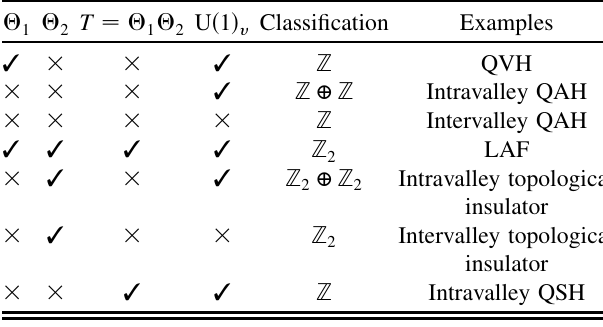
TABLE II. Classification of spinful SPT insulators on multi- layer graphene. Three kinds of time-reversal operators are con- sidered for classification because of the valley and spin dynamical degrees of freedom: ^(cid:2) ^(cid:2) / i(cid:5) , which acts on the spin indices, flips spin; and ^ T ¼ y 2 ^(cid:2) ^(cid:2) does both. a The upper three rows show that the classifi- 1 2 cation reduces to that of a spinless fermion if ^(cid:2) absent. The lower rows show new possibilities that emerge upon taking spins into account.